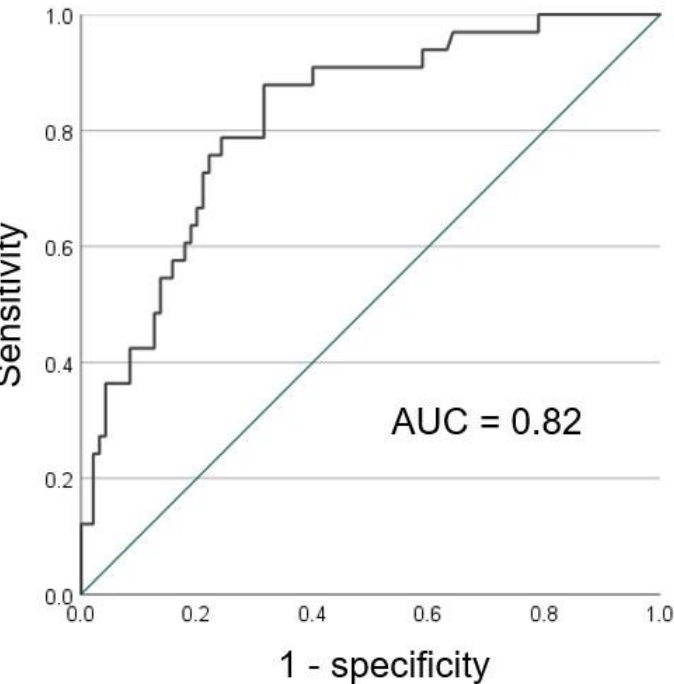
Figure 5. The ROC curve of CT-FVF (%) of the pancreas predicting the severity of pneumonia on